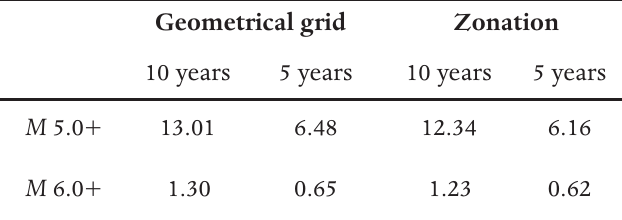
Table 1. Expected number of earthquakes for the 5-year and 10-year forecasting classes, over the whole territory under investigation, for the two spatial